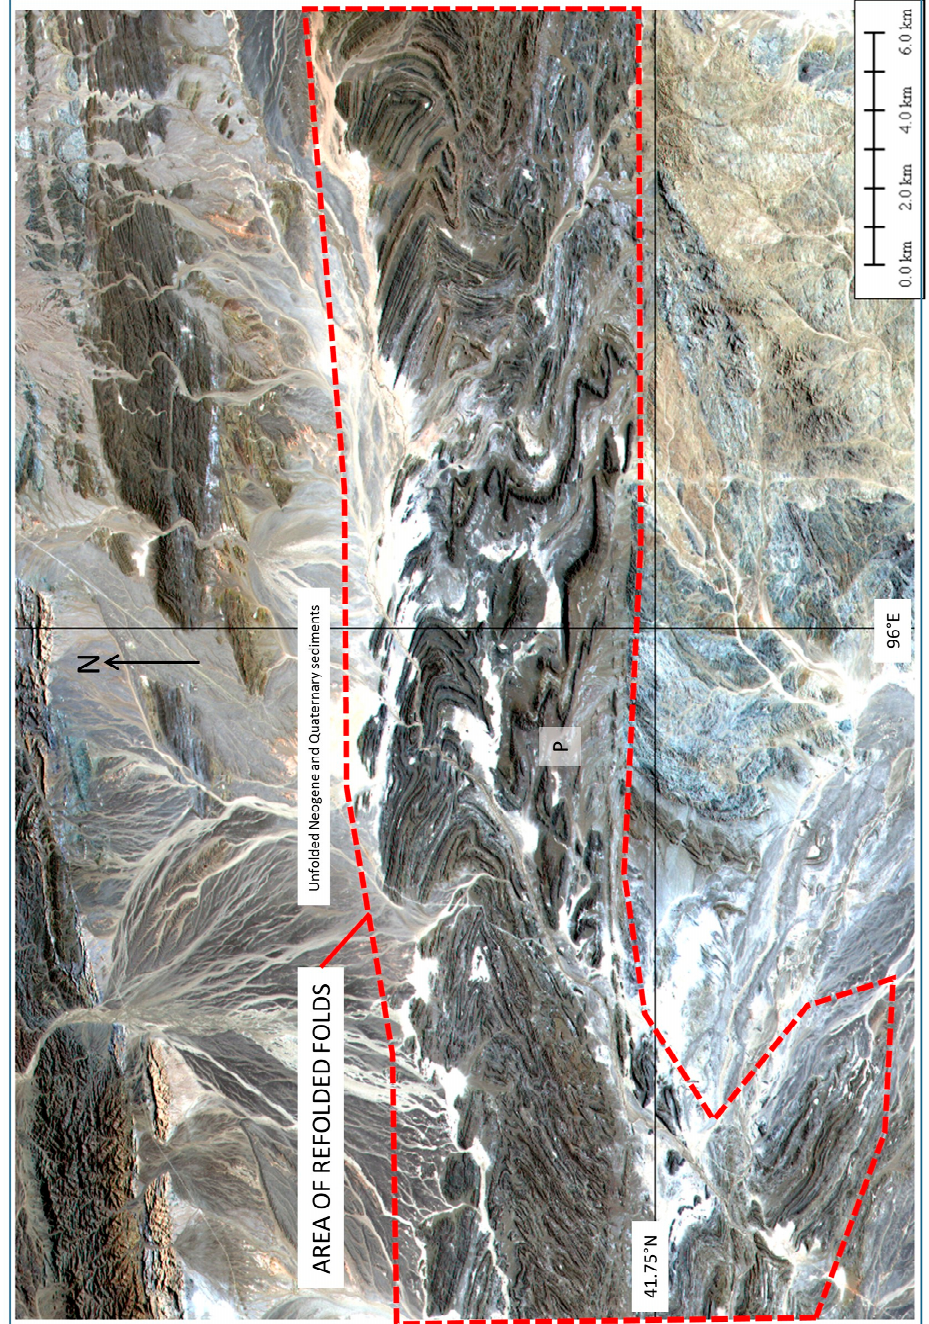
Figure 14. ALOS 10 m resolution multispectral image draped on SRTM-90 digital topography showing refolded Permian (P) succession in Hongyanjing Basin, central Beishan region, northwest China. See [68] for detailed fold interpretation and discussion. See Figure 1 for image location.